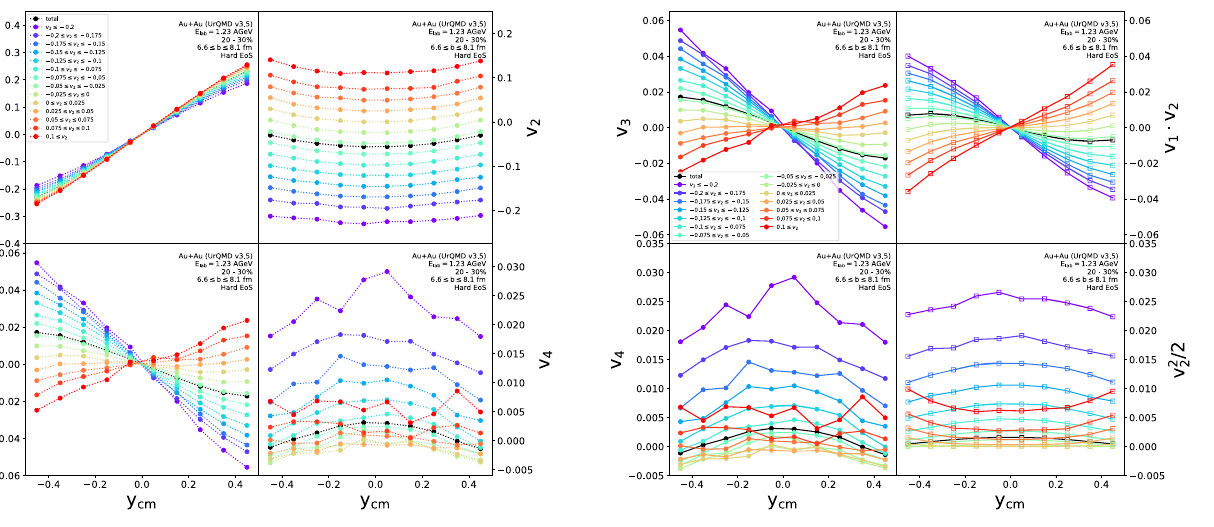
Fig. 2 Rapidity dependence of the flow coefficients v 1 (upper left), Fig. 3 The rapidity dependence of triangular flow v 3 (upper left) in v v v comparison to the multiplicative relation v 1 · v 2 (upper right) and the 2 (upper right), 3 (lower left) and 4 (lower right) in different event classes(fromthemostpositive v 2 classinredtomostnegative v 2 classin rapidity dependence of quadrangular flow v 4 (lower left) in comparison purple,seelegend)aswellasthetotal(i.e.withouteventclassselection) tothescalingrelation0 . 5 v 2 (lowerright)indifferenteventclasses(from 2 flow coefficient (black) for 20–30% peripheral Au+Au collisions with the most positive v 2 class in red to most negative v 2 class in purple, hard EoS at 1.23 AGeV from UrQMD see legend) as well as the total (i.e. without event class selection) flow coefficient(black)from20–30%peripheralAu+Aucollisionswithhard EoS at 1.23 AGeV from